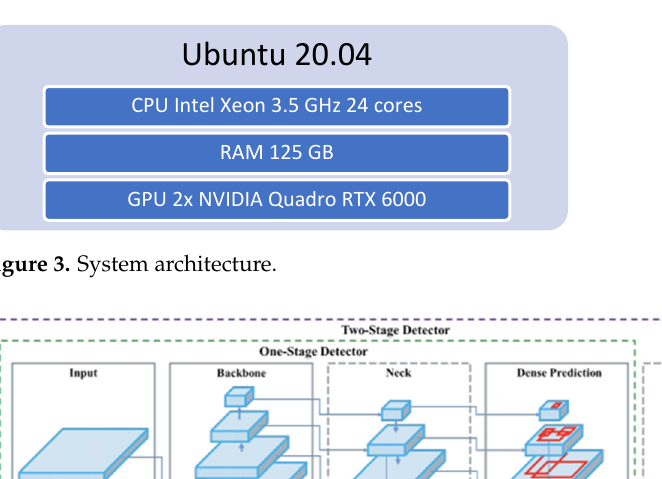
Figure 2. Annotation sample two. Black boxes are annotated R. obtusifolius leaves.